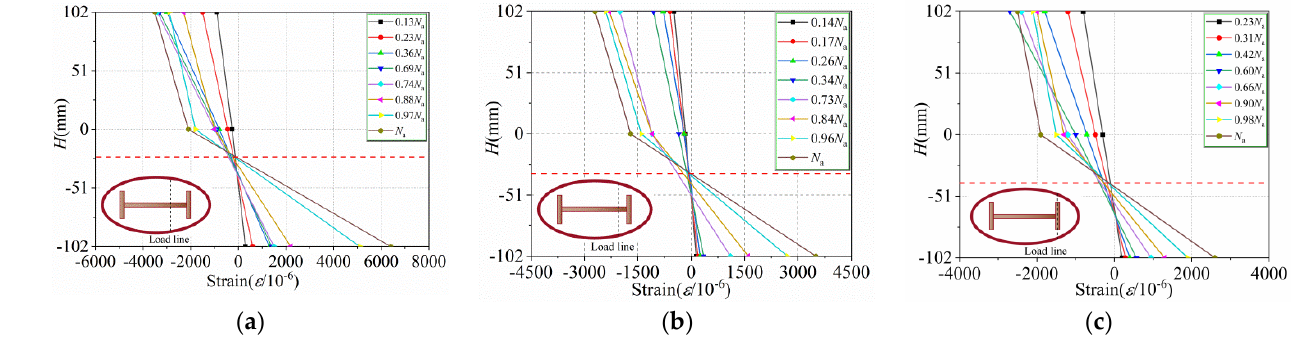
Figure 16. The mid-span section longitudinal strain distribution curves for three typical specimens: ( a ) HUCFEST−18; ( b ) HUCFEST−19; ( c ) HUCFEST−20.